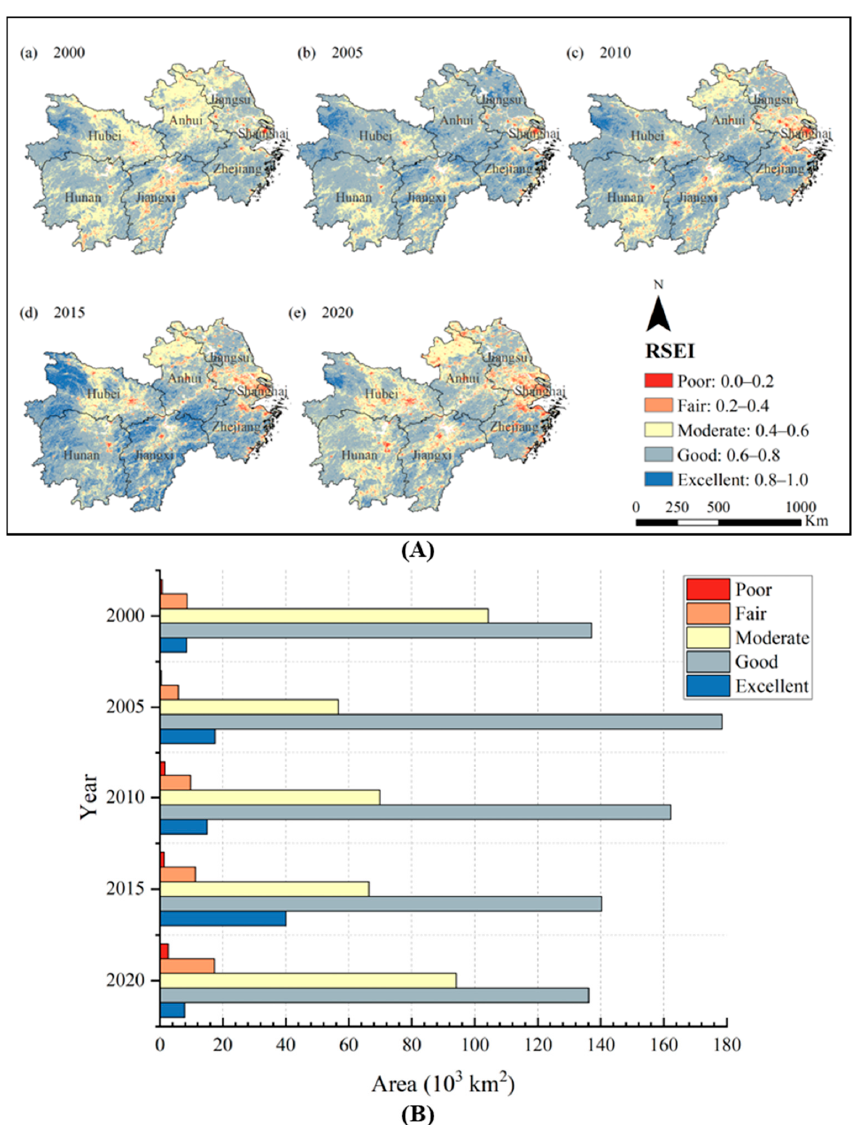
Figure 3. Spatial and temporal changes of RSEI in the YREBML during 2000 and 2020: ( A ) Spatial patterns of the RSEI; ( B ) RSEI area statistics of different categories. Note: Datum: D_WGS_1984; Projection: WGS_1984_UTM_Zone_50N; Representation scale: 1:17,000,000; Nominal scale: 1:250.